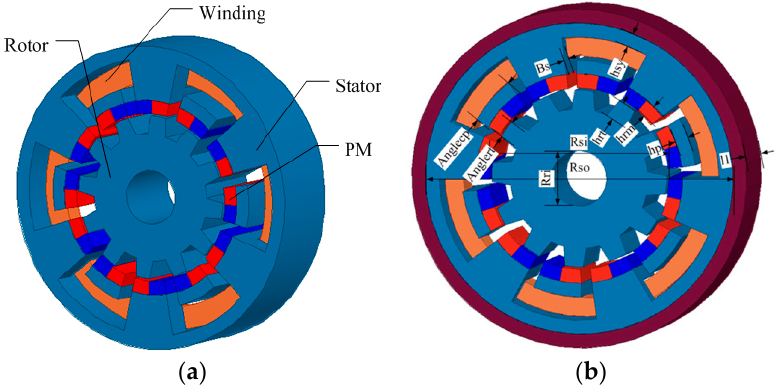
Figure 1. ( a ) Main topology of FRCPM; ( b ) Main dimension of FRCPM.